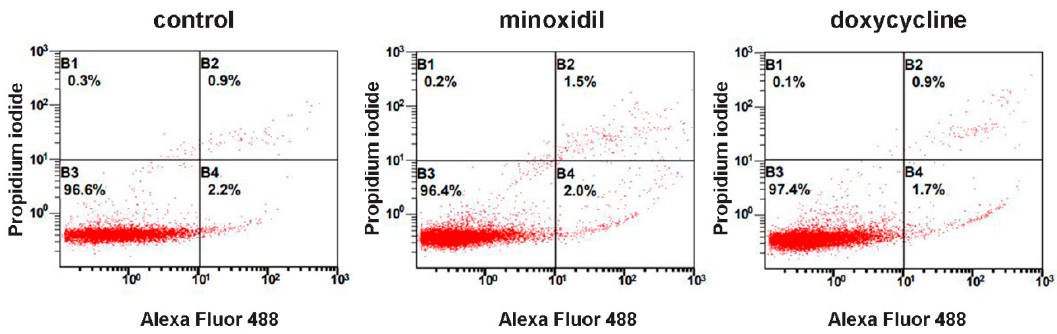
Figure 2. Neither minoxidil nor doxycycline is toxic to neutrophils under short-term exposure. Human neutrophils were cultured without additives or in the presence of 200 µM minoxidil or 20 µM doxycycline for 30 min. Immediately after that cells were stained with Annexin V, conjugated with Alexa Fluor 488 and propidium iodide, followed by flow cytometry analysis. Representative dot plots with proportions of viable (region B3), early apoptotic (region B4) and late apoptotic and necrotic cells (regions B2 and B1) are shown.